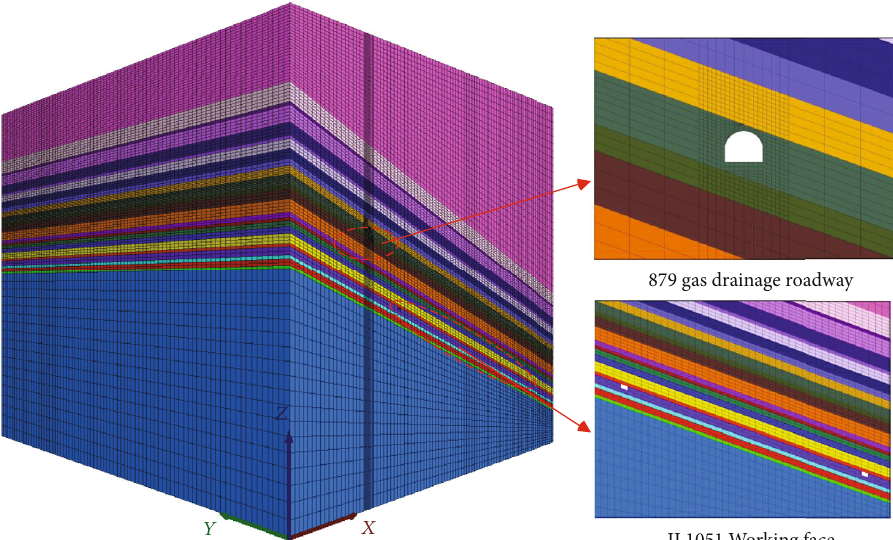
Figure 10: Grid diagram of numerical